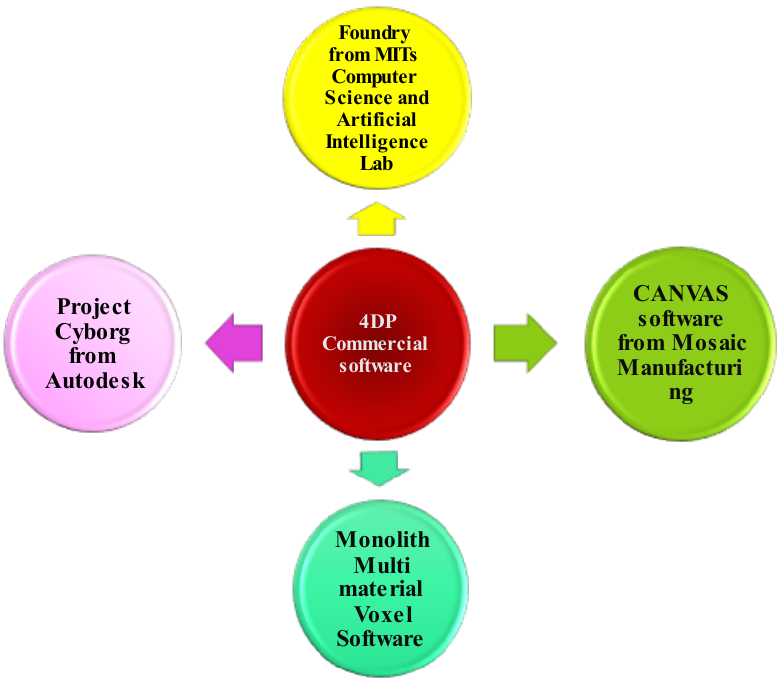
Figure 2. Some commercially available 4DP software: Foundry, Canvas, Monolith multi-material voxel and Project Cyborg. These software systems are used to make 4DP easier, efficient and cost- effective and are currently employed to control the shape-changing system in a well-ordered man- ner.